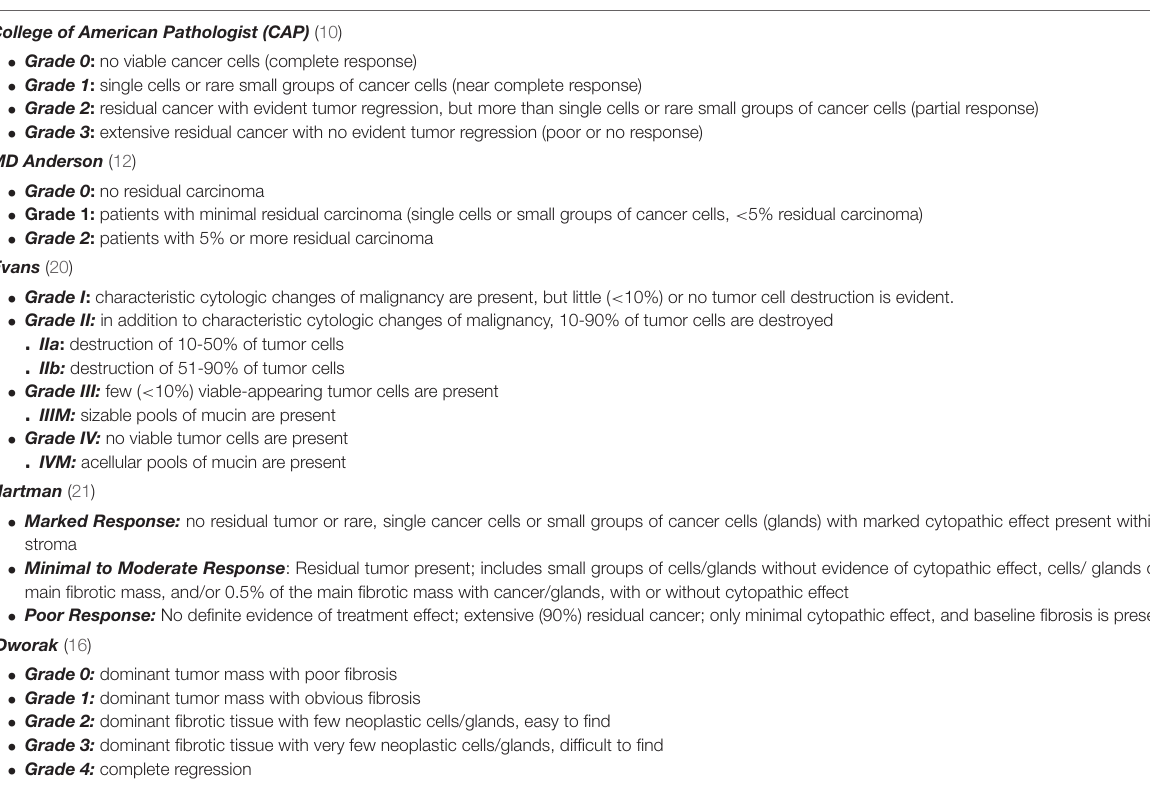
TABLE 1 | Regression grading systems applied in the study. College of American Pathologist (CAP)